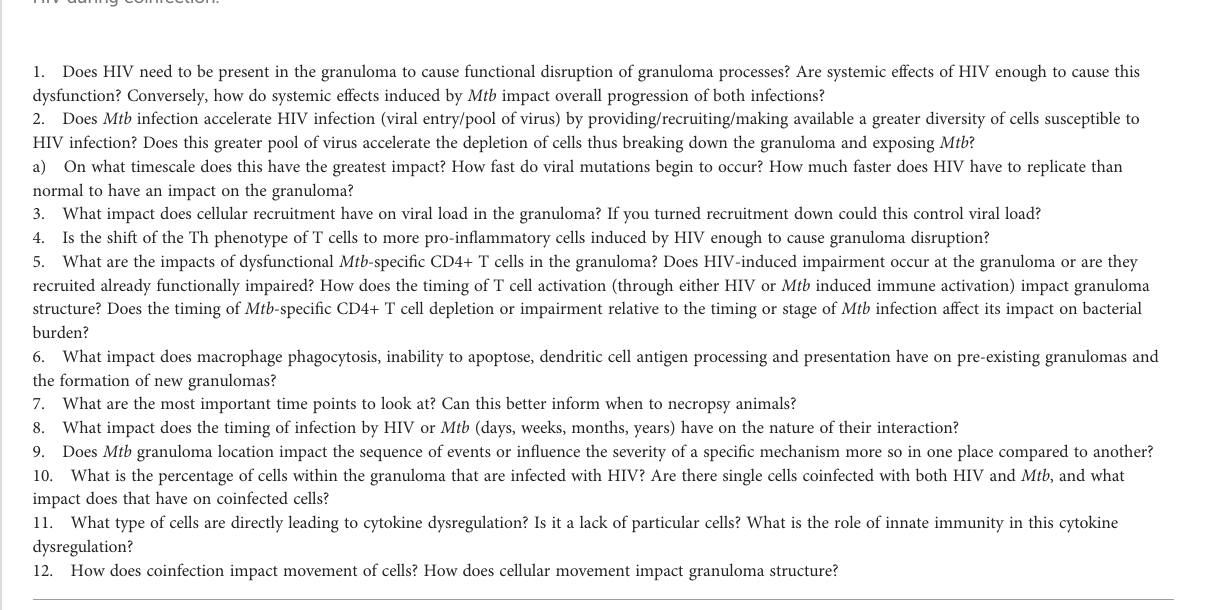
Box 1: Summary of outstanding questions related to the role of the granuloma in Mtb -HIV coinfection as well the synergy between Mtb and HIV during